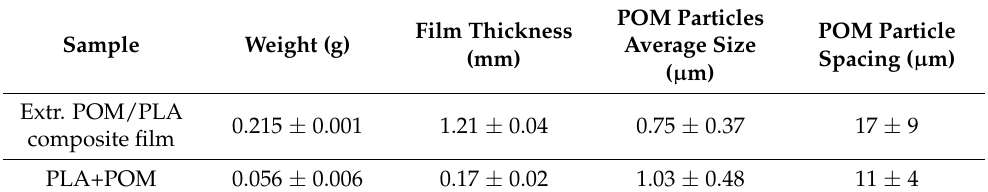
Figure 4. SEM image of solvent casted films: ( a ) POM/PLA film; ( b ) blank PLA film at 1000x mag- nification.